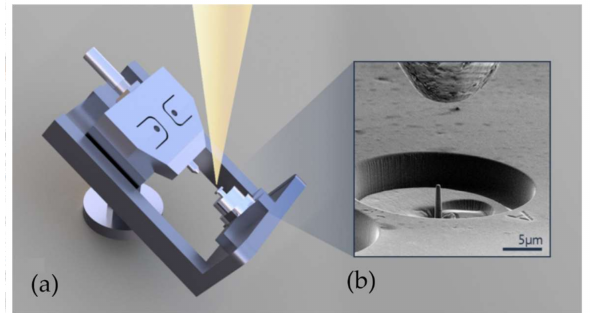
Figure 2. An illustration of the experimental setup: ( a ) pre-tilted frame of the Alemnis in-chamber nanoindenter; ( b ) scanning electron microscope (SEM) image from a 70 ◦ tilt angle showing the single crystal diamond flat punch hovering over a focused ion beam (FIB)-fabricated